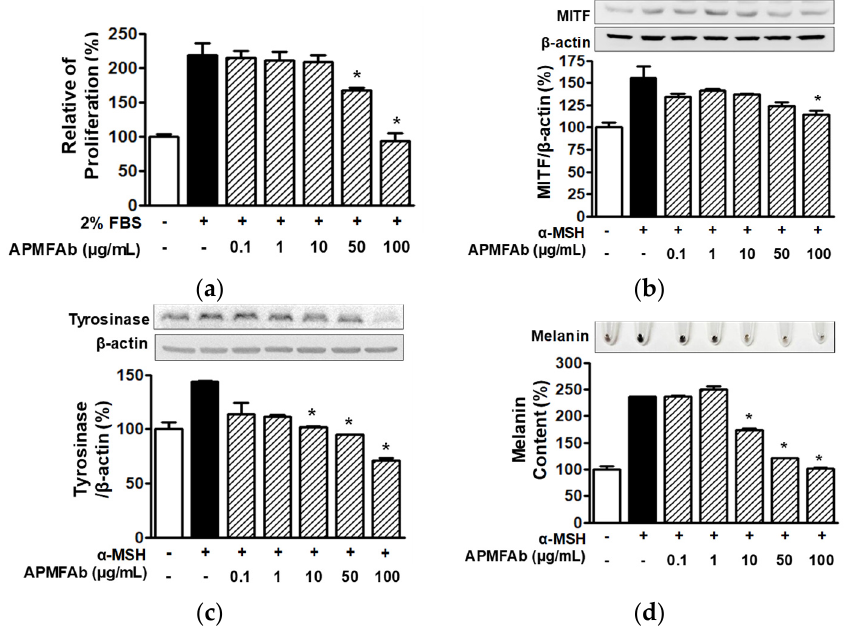
Figure 5. Effects of Angelica polymorpha Maxim. flower absolute on melanogenesis-associated re- sponses in B16BL6 melanoma cells. ( a ) Cell proliferation. B16BL6 melanoma cells were incubated in DMEM in the presence or absence of 2% ( v / v ) FBS with or without APMFAb (0.1–100 μ g/mL) for 48